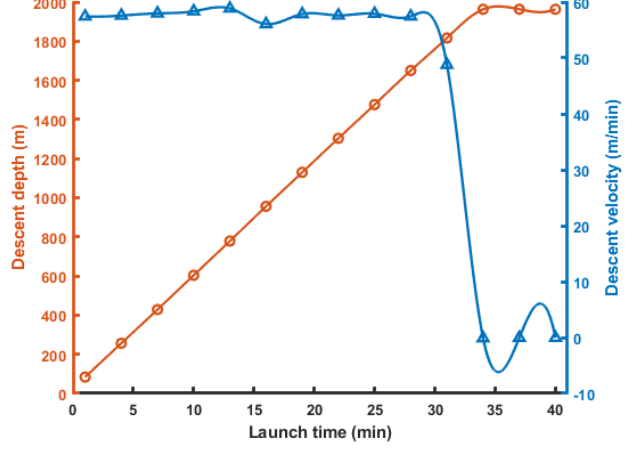
Figure 18. Relationship curve of descent depth versus time and descent velocity versus time.